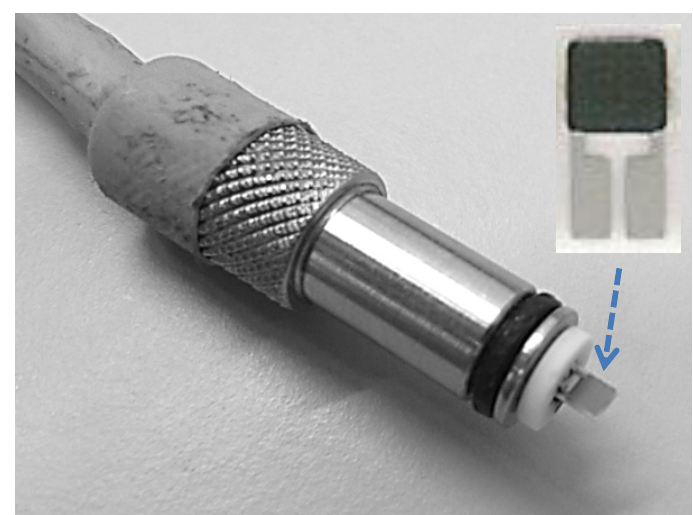
Figure 4. Picture of the home-made